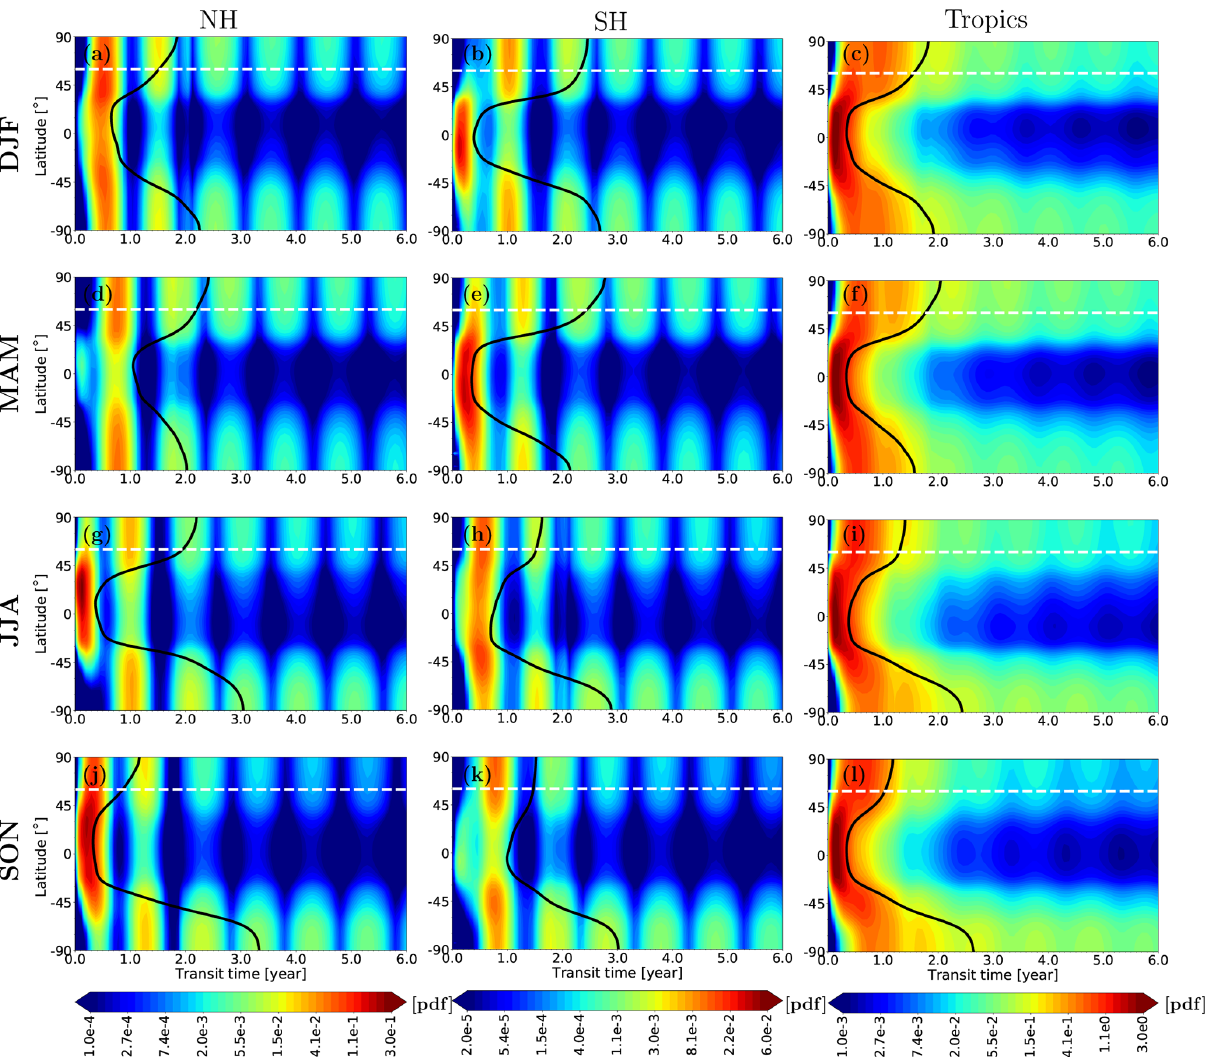
Figure 4. Age spectra as (partial) transit time probability density functions (PDFs), calculated for air originating from three source regions: NH extratropics, SH extratropics, and tropics. Age spectra are shown at θ = 360K (destination region) for all seasons. For each season, the sum of the integral of the age spectra over all three source regions (i.e., over all partial contributions) is ∼ 1, with deviations caused by our approximation limiting the maximal transit time to 10 years. The black line shows the mean AoA as derived from the age spectrum. White dashed line marks 60 ◦ N